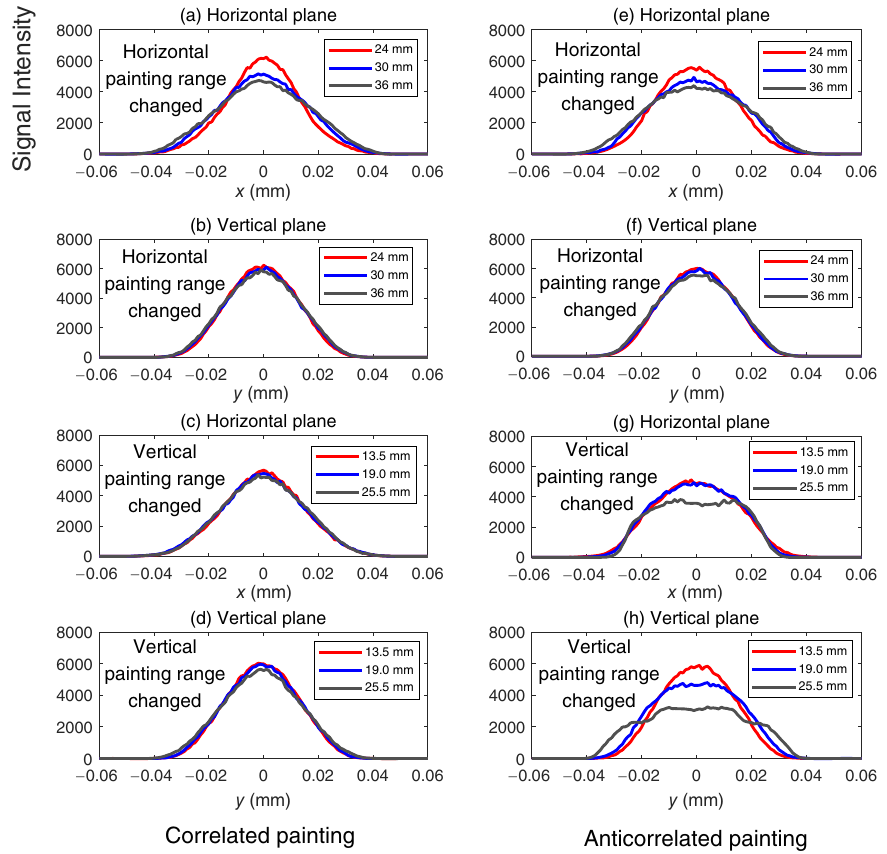
FIG. 10. Comparison of the simulation results of the transverse coupling effects for the correlated and anticorrelated painting. Subgraphs (a), (b), (e), and (f): the horizontal painting range was changed with the vertical painting range fixed to 17.5 mm; subgraphs (c), (d), (g), and (h): the vertical painting range was changed with the horizontal painting range fixed to 27 mm.